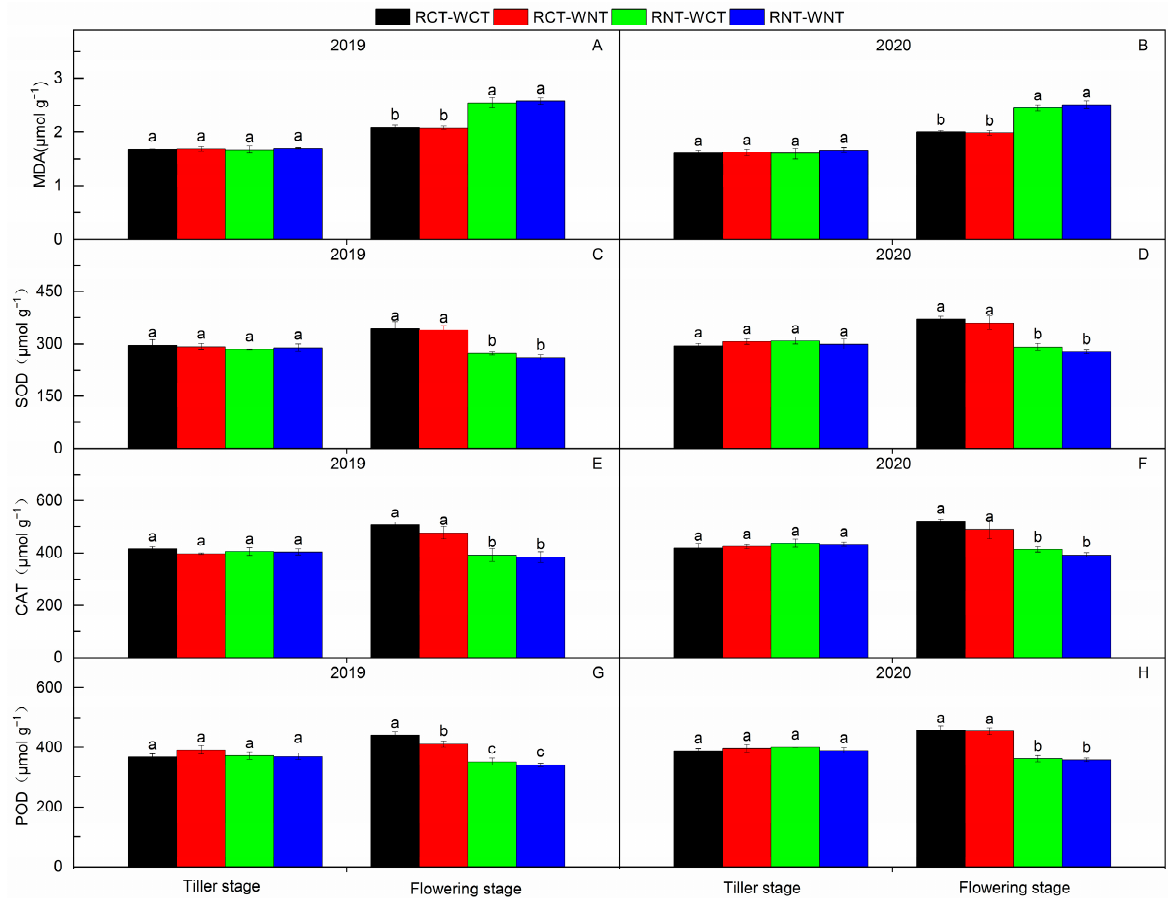
Figure 4. MDA in 2019 ( A ) and 2020 ( B ), superoxide dismutase (SOD) in 2019 ( C ) and 2020 ( D ), catalase (CAT) in 2019 ( E ) and 2020 ( F ), and peroxidase (POD) in 2019 ( G ) and 2020 ( H ) of rice under different tillage management methods. RCT–WCT, conventional tillage before transplantation/sowing of each crop; RNT–WCT, no tillage before transplantation of rice and conventional tillage before sowing of wheat; RCT–WNT, conventional tillage before transplantation of rice and no tillage before sowing of wheat; RNT–WNT, no tillage before sowing of each crop. Different lowercase letters indicate statistical differences among treatments at p < 0.05. Table 1. Effects of the spike number m − 2 , grains per spike, 1000-grain weight (g), and yield (t ha − 1 ) under different tillage treatments. RCT-WCT: conventional tilling before transplantation/sowing of each crop; RNT-WCT: no tilling before transplantation of rice and conventional tilling before sowing of wheat; RCT-WNT: conventional tilling before transplantation of rice and no tilling before sowing of wheat; RNT-WNT: no tilling before sowing of each crop. ns: no significant effects; *: significant effect at the p < 0.05 level; **: significant effect at the p < 0.01 level. Those values within a column among the same year followed by the same letter are not significantly different according to Duncan’s test (0.05).